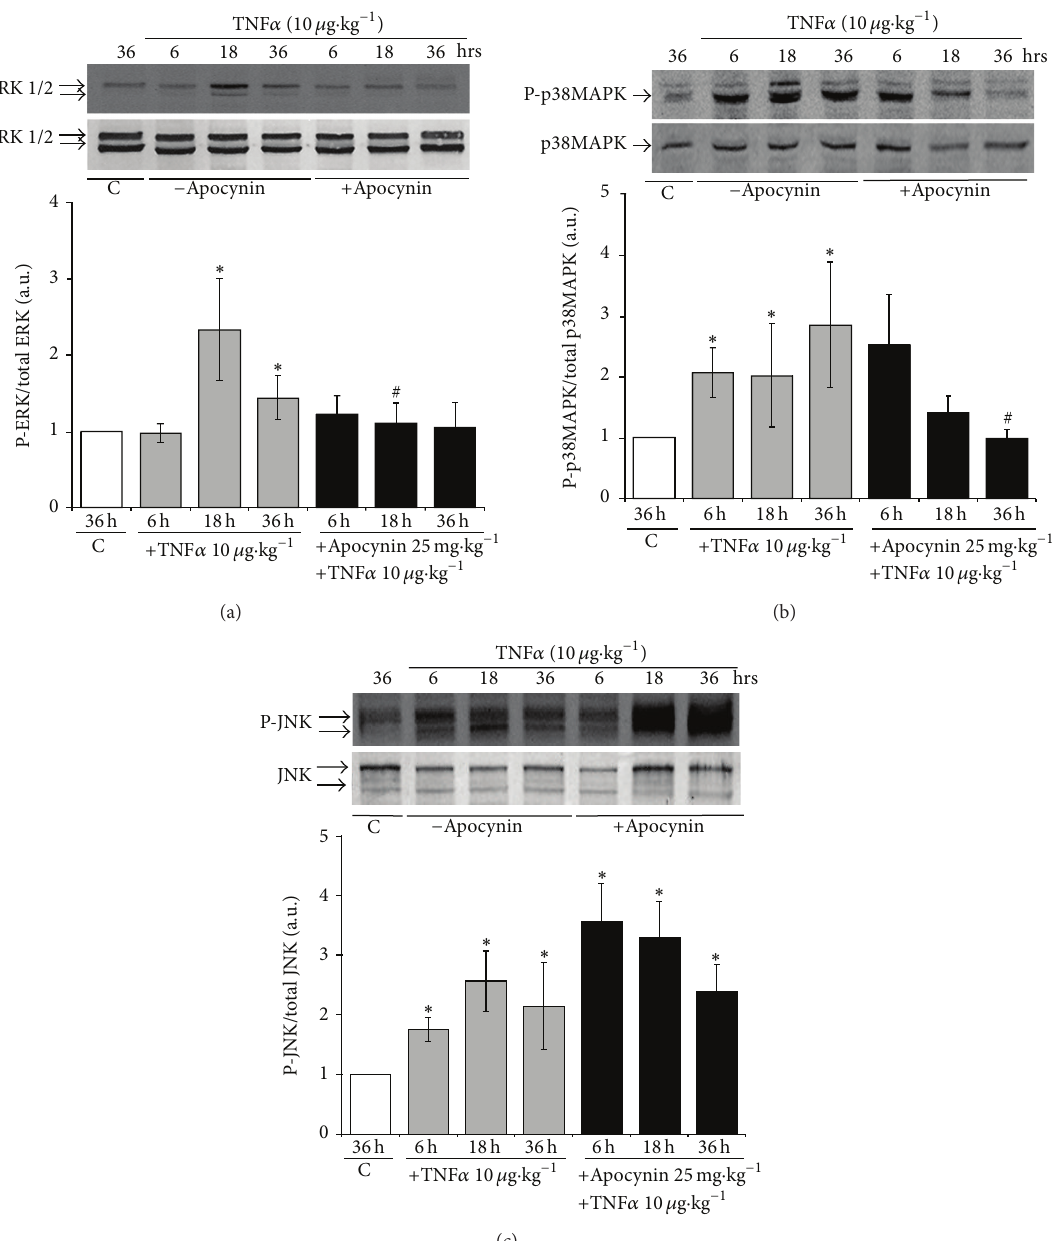
Figure 8: Redox-sensitive MAP kinases are activated in the colon of TNF 𝛼 -treated mice: modulation by apocynin. (a) Upper: ERK1/2 activation was assessed by Western blot using phospho-ERK1/2 specific antibodies in colon of mice treated with TNF 𝛼 (10 𝜇 g ⋅ kg −1 , ip) in the presence or absence of apocynin (25 mg ⋅ kg −1 , ip) (C in the figure is for control untreated mice). Total ERK1/2 protein, assessed with an ERK1/2 antibody, was used as loading control. Lower: densitometric analysis of the ratio of phospho-ERK1/2 to total ERK1/2 protein. Data are expressed as means ± S.E.M from 𝑛 = 5 mice in each group. ∗ 𝑃 < 0.05 , ∗∗ 𝑃 < 0.01 , and ∗∗∗ 𝑃 < 0.001 versus control; # 𝑃 < 0.05 , ## 𝑃 < 0.01 , and ### 𝑃 < 0.001 versus TNF 𝛼 . (b) Upper: p38MAPK activation was assessed by Western blot using phospho-p38MAPK specific